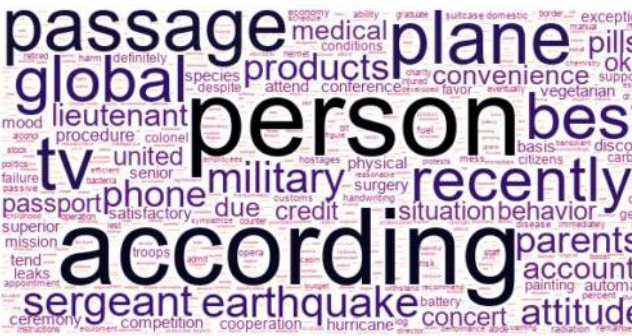
Figure 3. Word cloud of the CEFR B1 level word list.